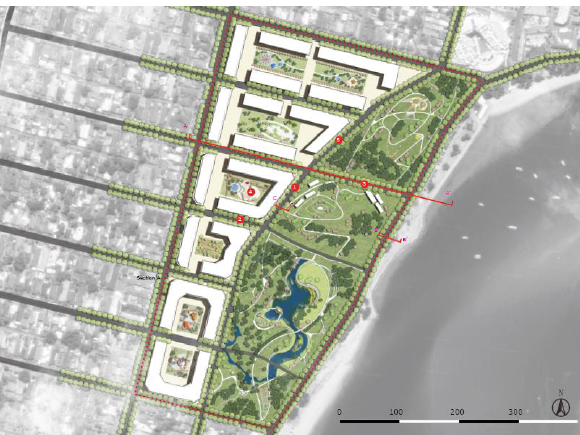
Figure 7: Booker Bay coastal resilience